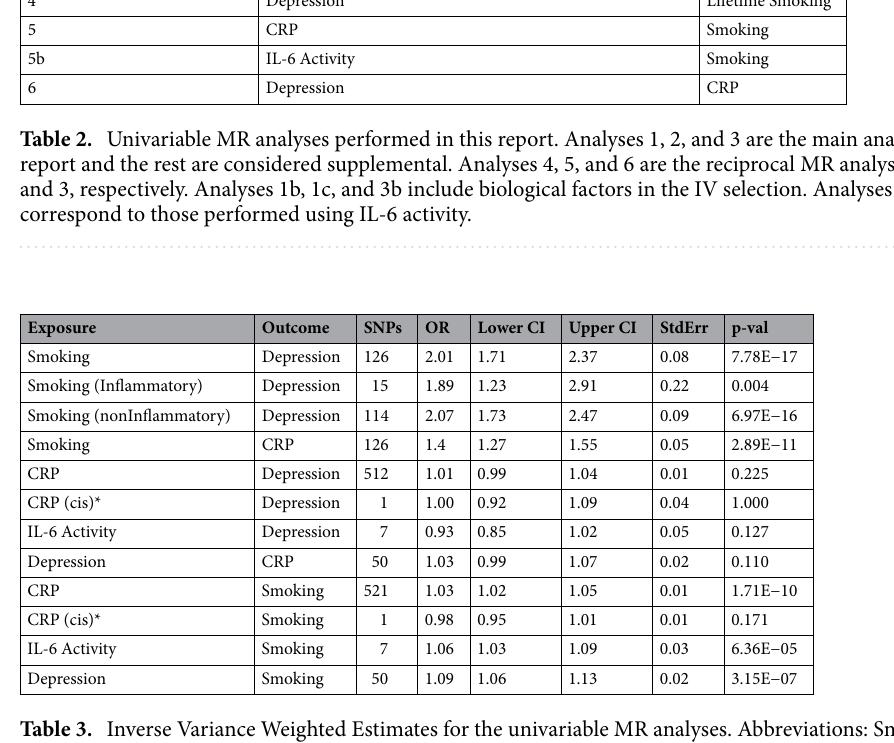
Table 3. Inverse Variance Weighted Estimates for the univariable MR analyses. Abbreviations: Smoking (Inflammatory) indicates smoking IVs previously associated with inflammation. Smoking (non Inflammatory) indicates smoking IVs not previously associated with inflammation. “Low CI” lower limit of 95% confidence interval. “Up CI” upper limit of 95% confidence interval.’ *Wald ratios were used to obtain the estimate for the CRP (cis)